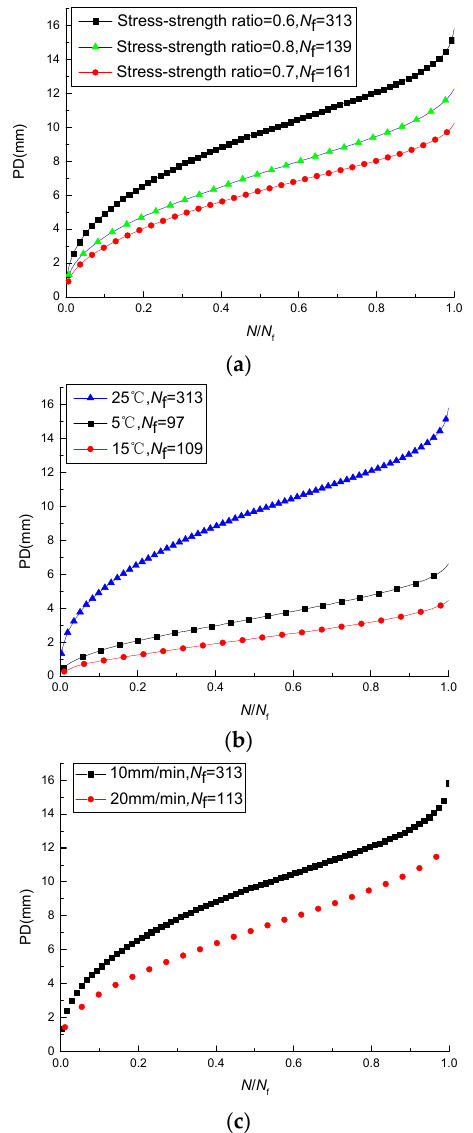
Figure 9. PDs under different test conditions: ( a ) PDs at different stress-strength ratios; ( b ) PDs at different temperatures; ( c ) PDs at different loading rates.